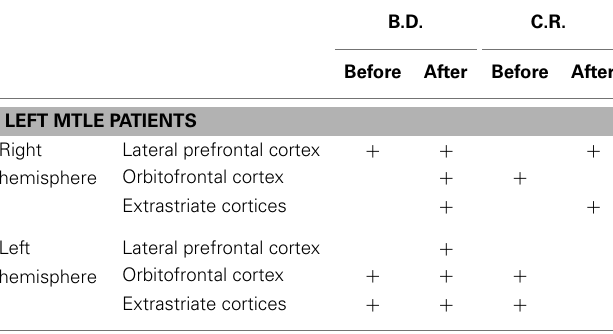
Table 4 | Main activated regions for fearful faces before and after lobectomy in left MTLE patients